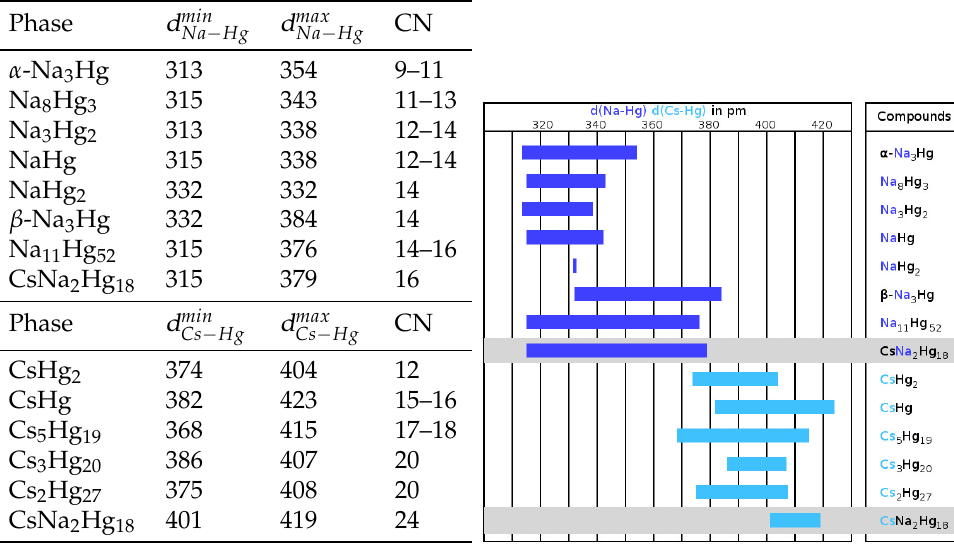
Figure 2. Na–Hg and Cs–Hg interatomic distances (in pm) and coordination numbers vs. Hg in CsNa 2 Hg 18 in comparison to those found in the literature [5,6,8,11,50–55] for binary Na and Cs amalgams, respectively.